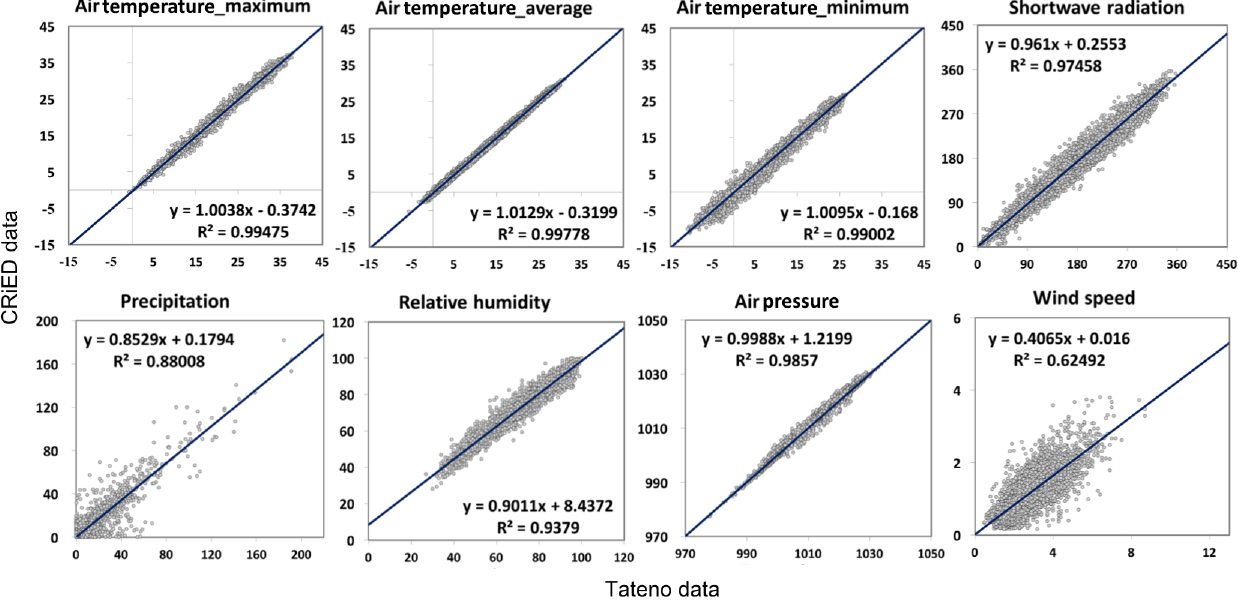
Figure 2. Comparisons of the EDP data with the Tateno data from the Japan Meteorological Agency from 1981 to 2017. Further parameter information is found in Table